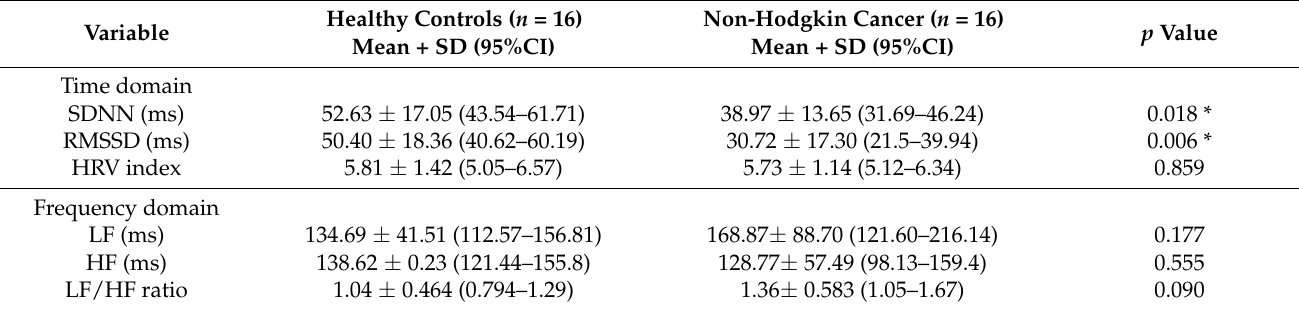
Table 3. Comparison of the dependent variables of heart rate variability (HRV) between the study